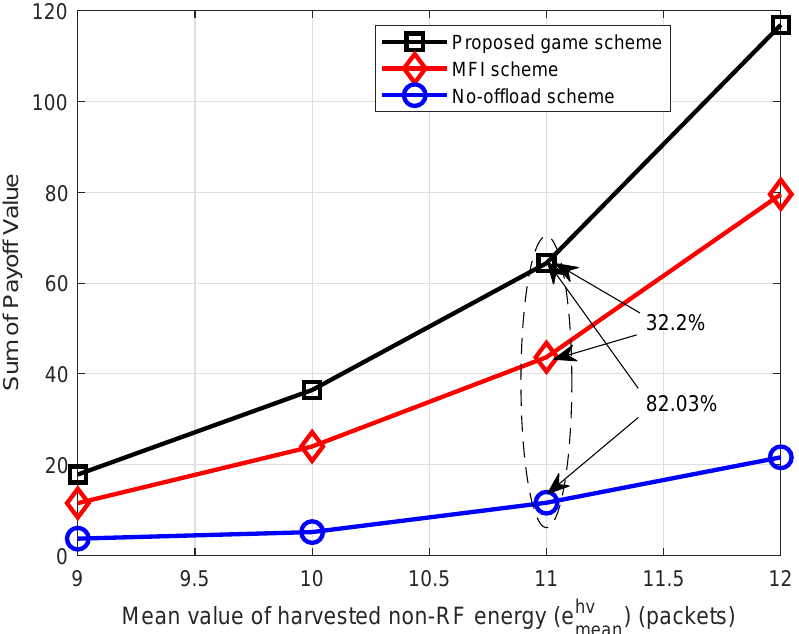
Figure 5. The influence of mean harvested non-RF energy on total payoff of the network when mean value of harvested non-RF energy is changed from 9 to 12 packets.